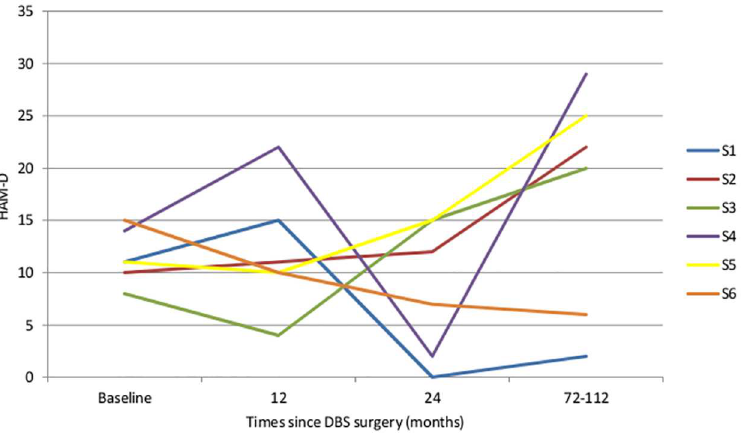
Fig 2. Depressive symptoms across follow-up period. HAM-D = HamiltonRating Scale for Depression. To improvethe clarity of the graph, only data collectedat 12 months, 24 months, and at long-term follow-up were includedin the